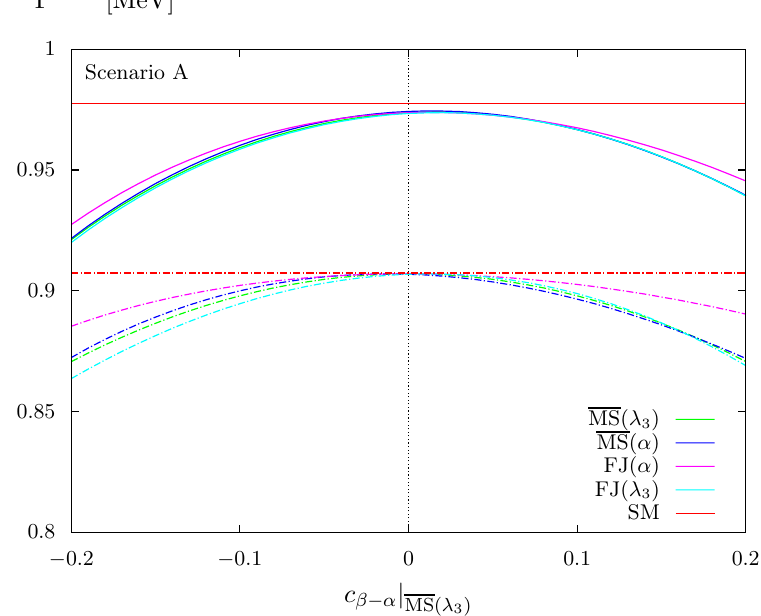
Figure 7 . The decay width for h 4 f at LO (dashed) and full NLO EW+QCD (solid) for ! scenario A in dependence of c (cid:12) (cid:0) (cid:11) . The input values are de(cid:12)ned in the MS( (cid:21) 3 ) scheme and are converted to the other schemes at NLO (also for the LO curves). The results computed with di(cid:11)erent renormalization schemes are displayed with the colour code of (cid:12)gure 5, and the SM (with SM Higgs-boson mass M h ) is shown for comparison in